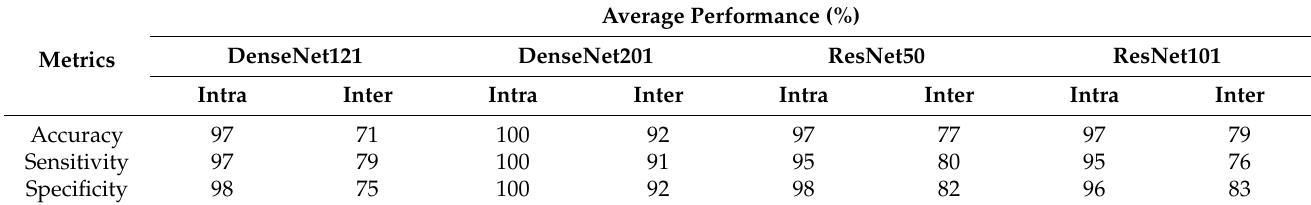
Table 4. Average performance with intra- and inter-patient scenarios.